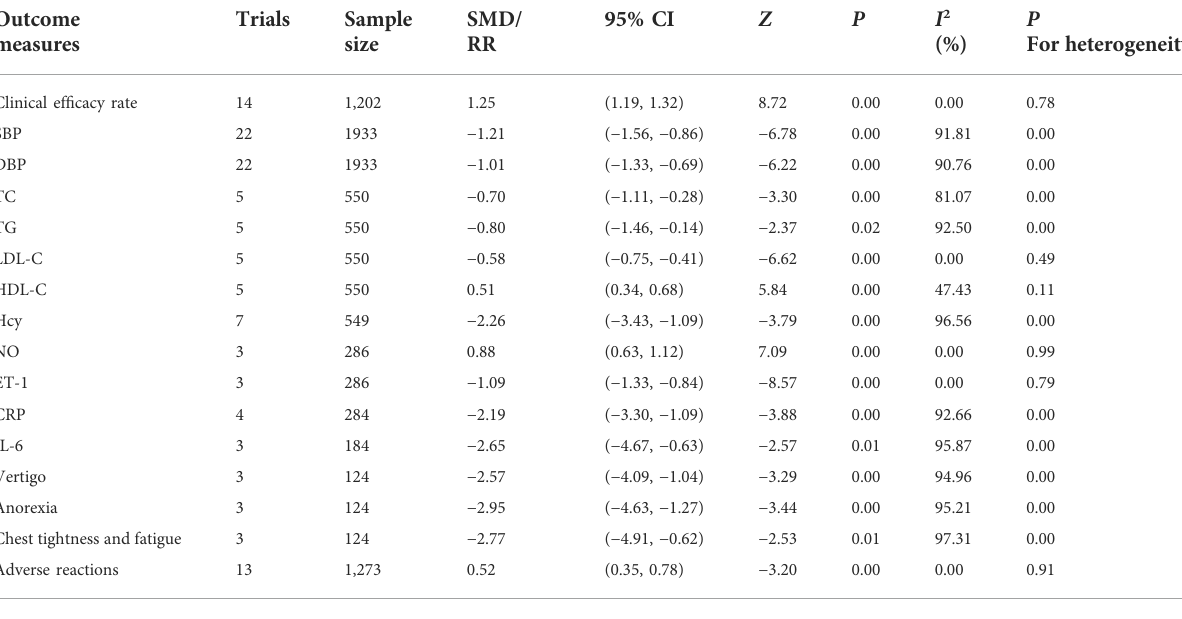
TABLE 2 Calculation results of the meta-analysis.